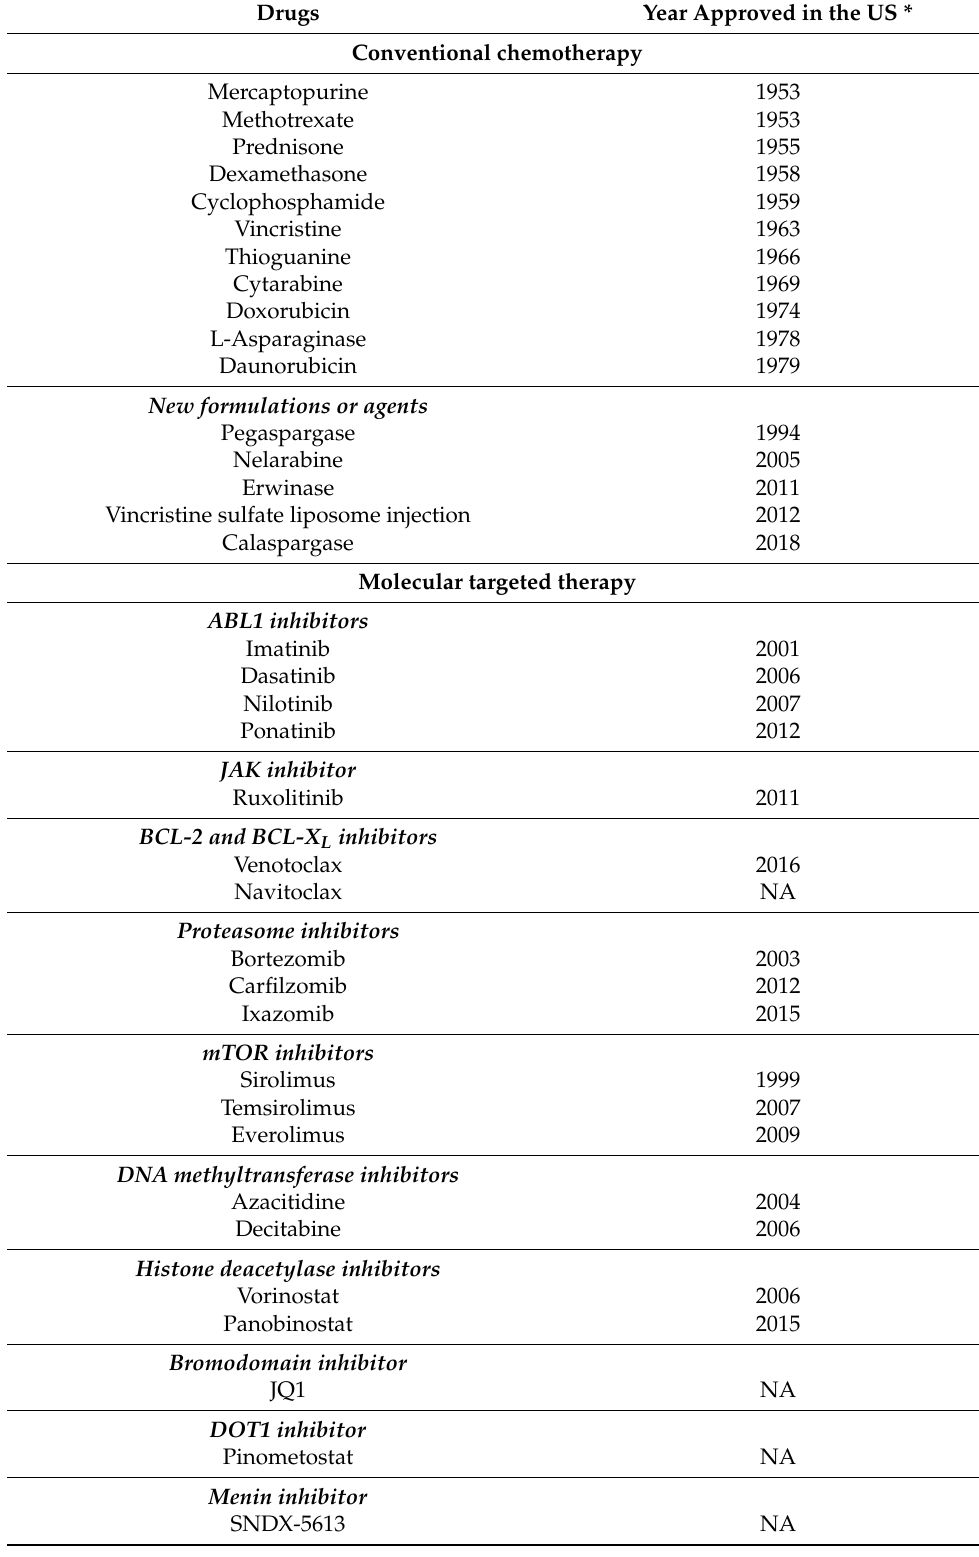
Table 1. Representative medications used in the treatment of patients with acute lymphoblastic leukemia and the year of US Food and Drug Administration